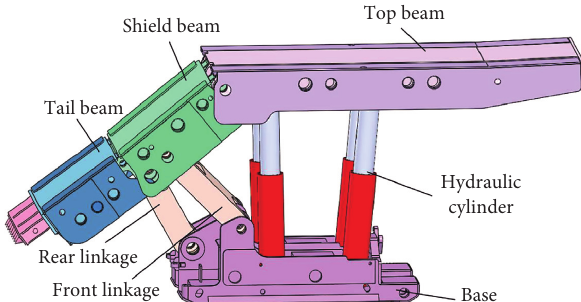
Figure 3: The model of the top-coal caving hydraulic